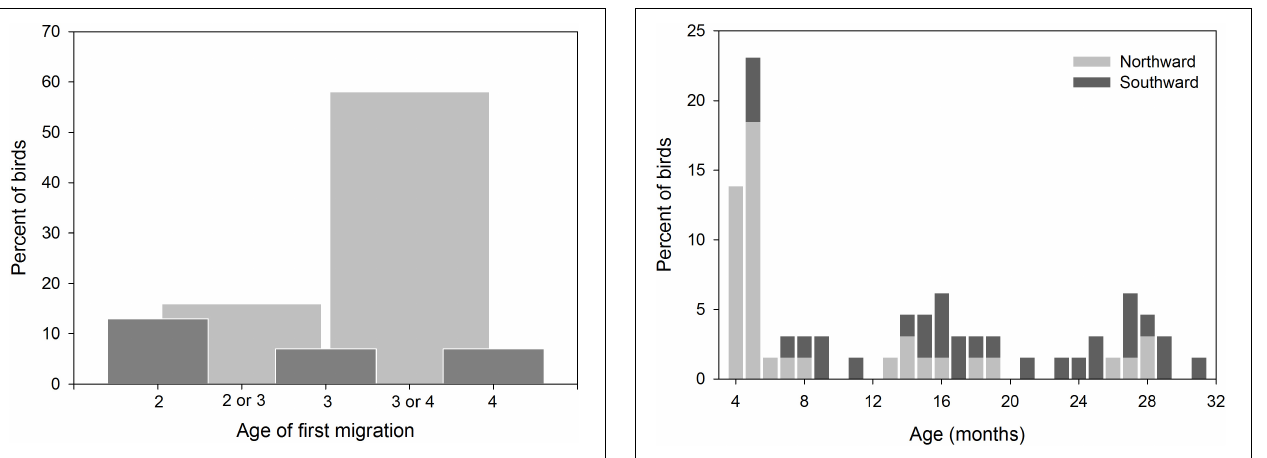
FIGURE 8 | Age of first northward migration for bar-tailed godwits caught aged 1 or 2 in New Zealand. Dark bars represent confirmed ages of migration; pale bars indicate those where the year of migration could not be confirmed to one of the two possible ages. N = 92 birds of 225 marked.